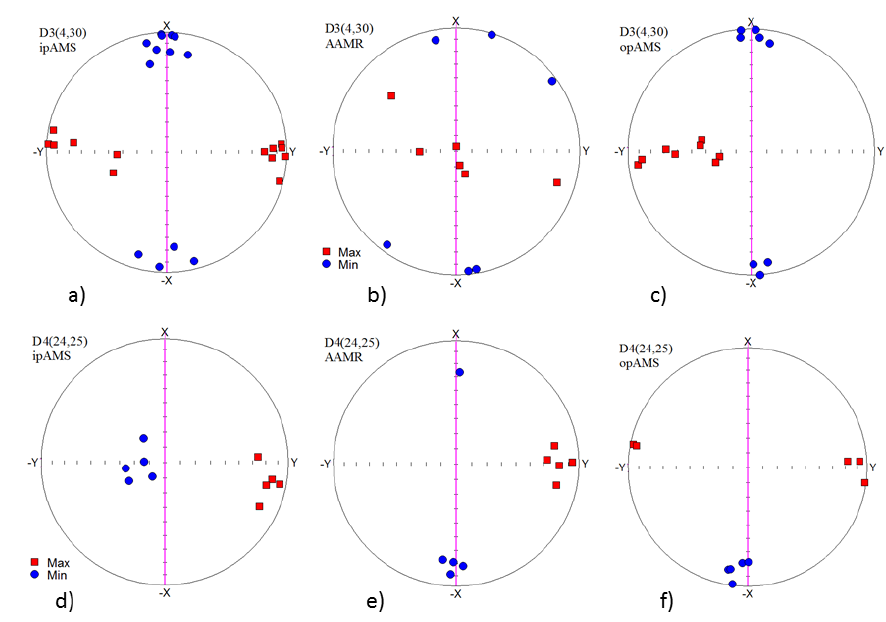
Figure 8. Domains D3 and D4 with inverse magnetic fabric ( a , d —ipAMS; b , e —AAMR; c , f —opAMS). Dyke coordinate system, equal-area projection on lower hemisphere.